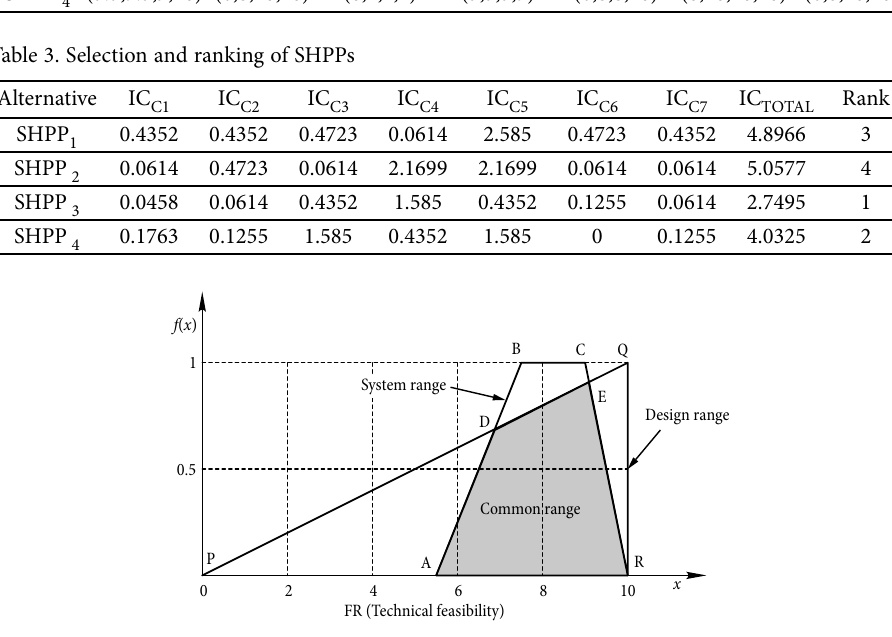
Fig. 5. SR, DR and CR for technical feasibility criterion of SHPP